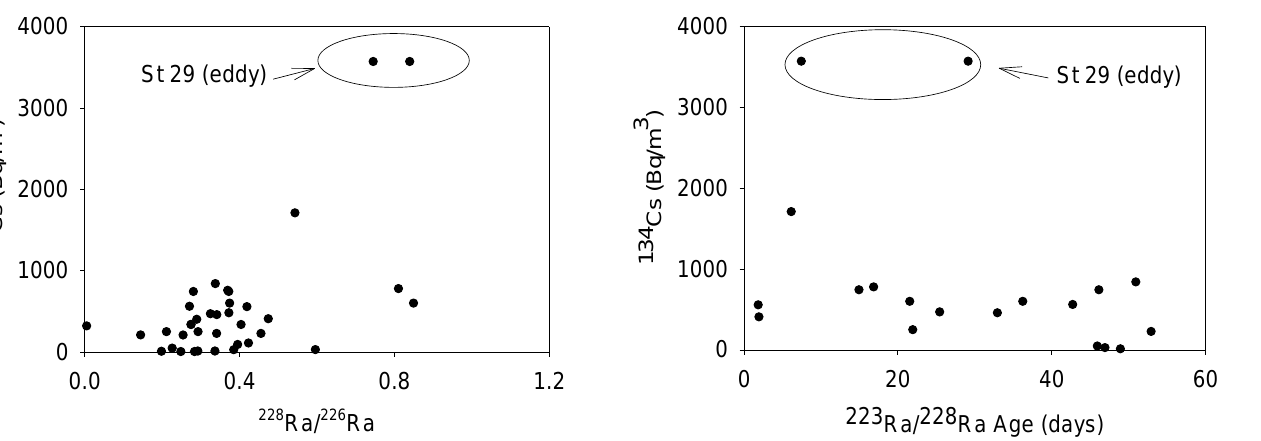
Fig. 3. The relationship between the 228 Ra / 226 Ra activity ratio and 134 Cs (Bqm − 3 ). Note the highest 134 Cs in eddy at station 29 also has a high 228 Ra / 226 Ra, suggesting that the water in this eddy came from the cooling of the reactors with Ra-rich coastal water.